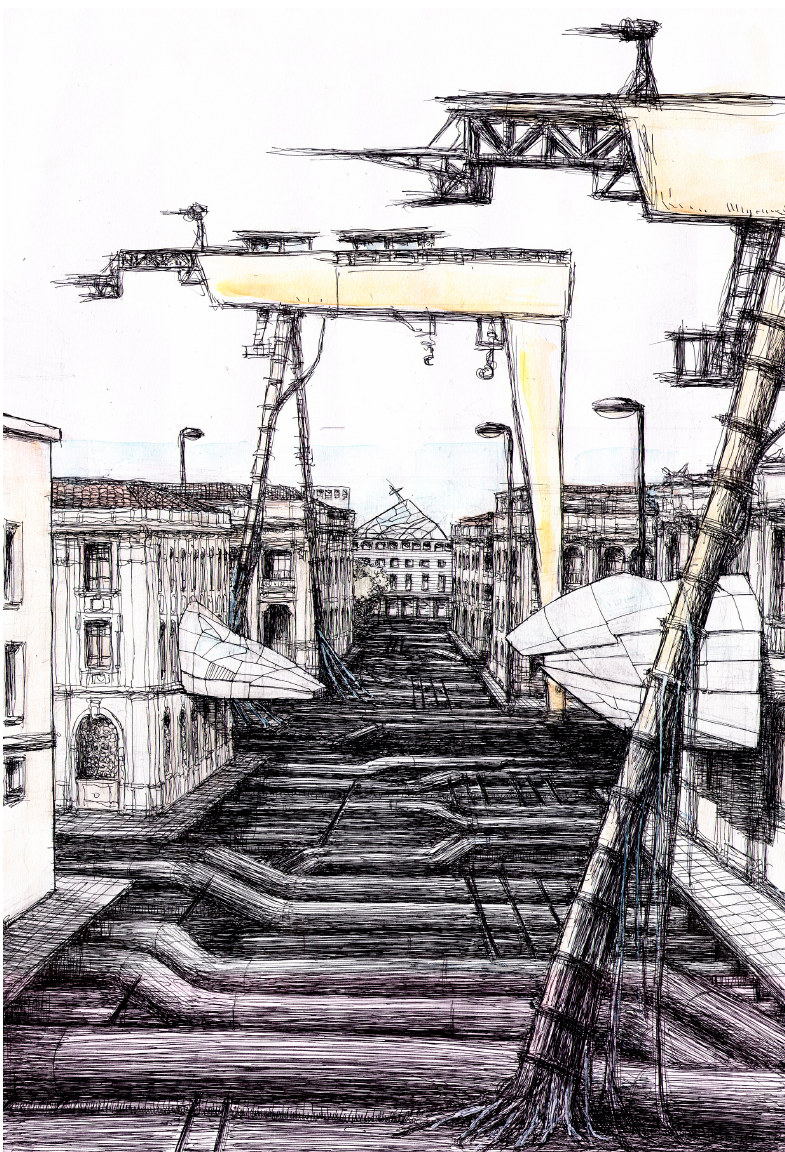
Figure 10. Michela De Domenico,